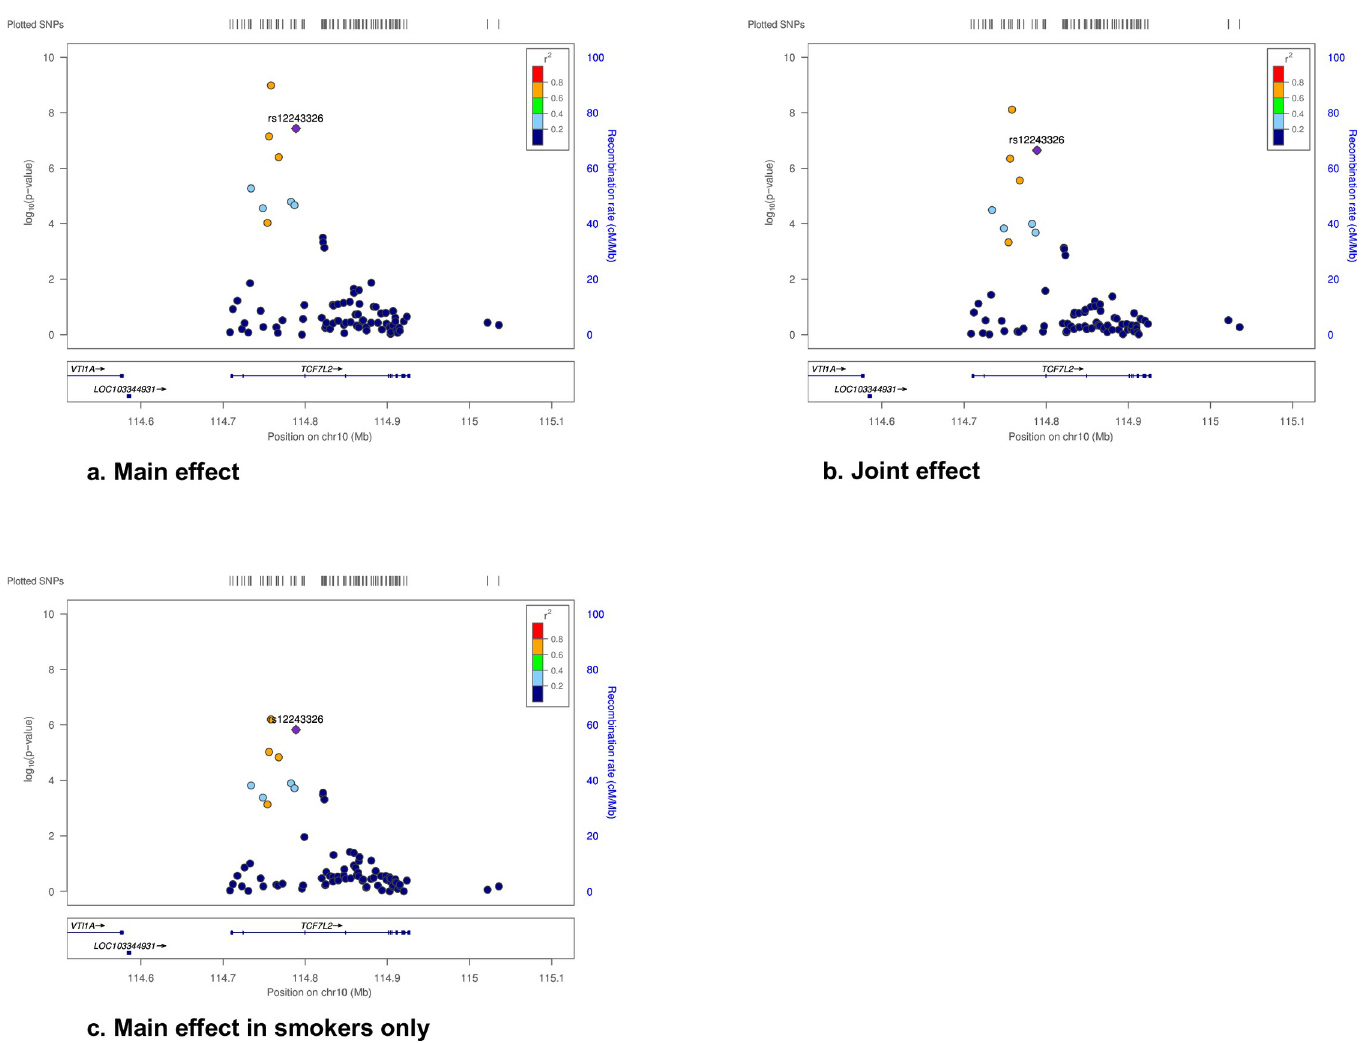
Fig 1. Regional plots for the association of rs1224336 in TCF7L2 with